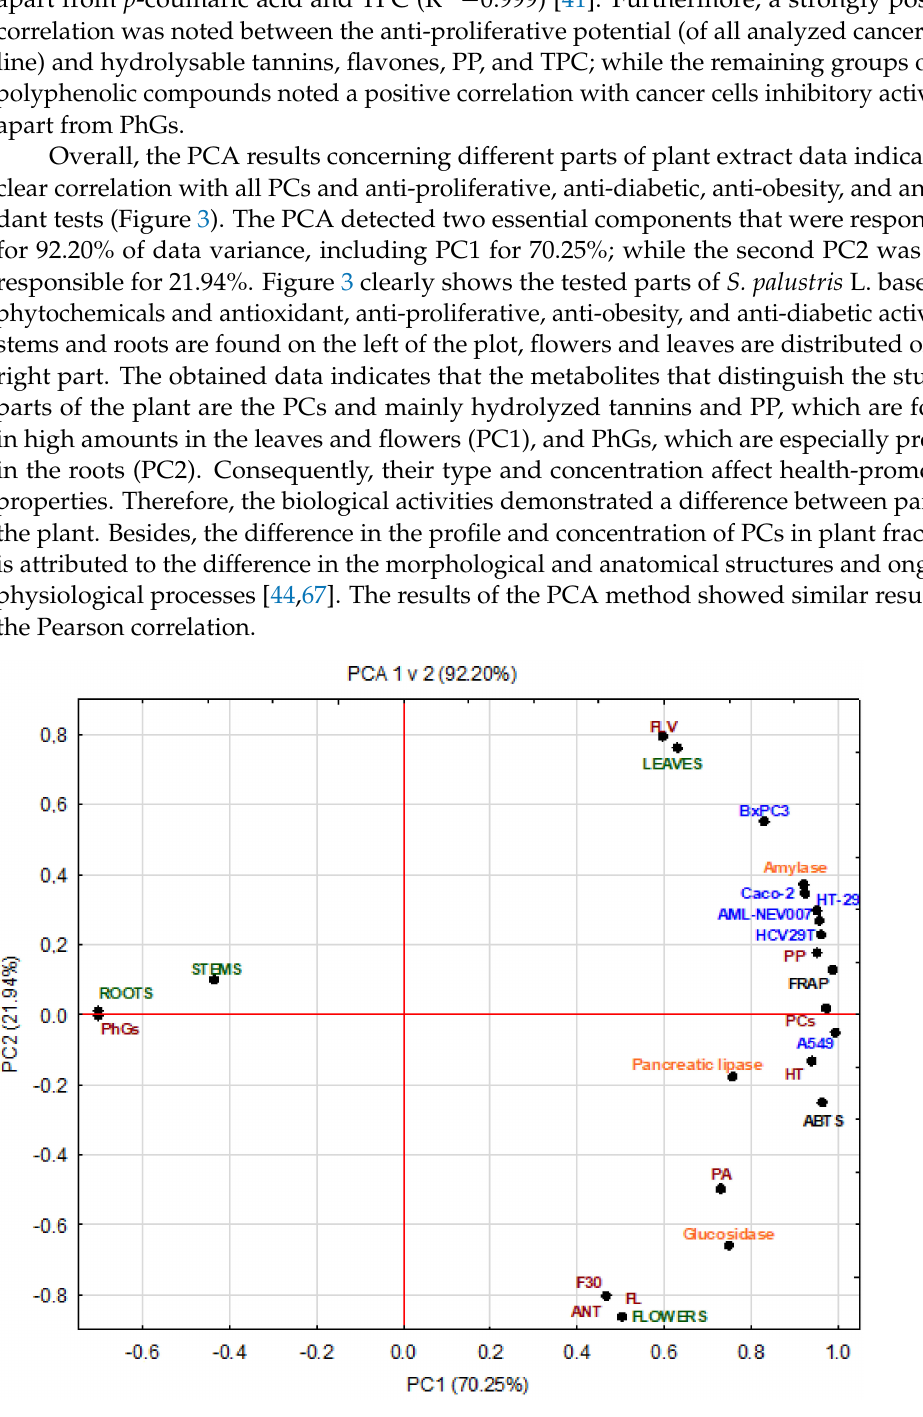
Figure 3. PCA of bioactive compounds and biological activities for all parts of Stachys palustris